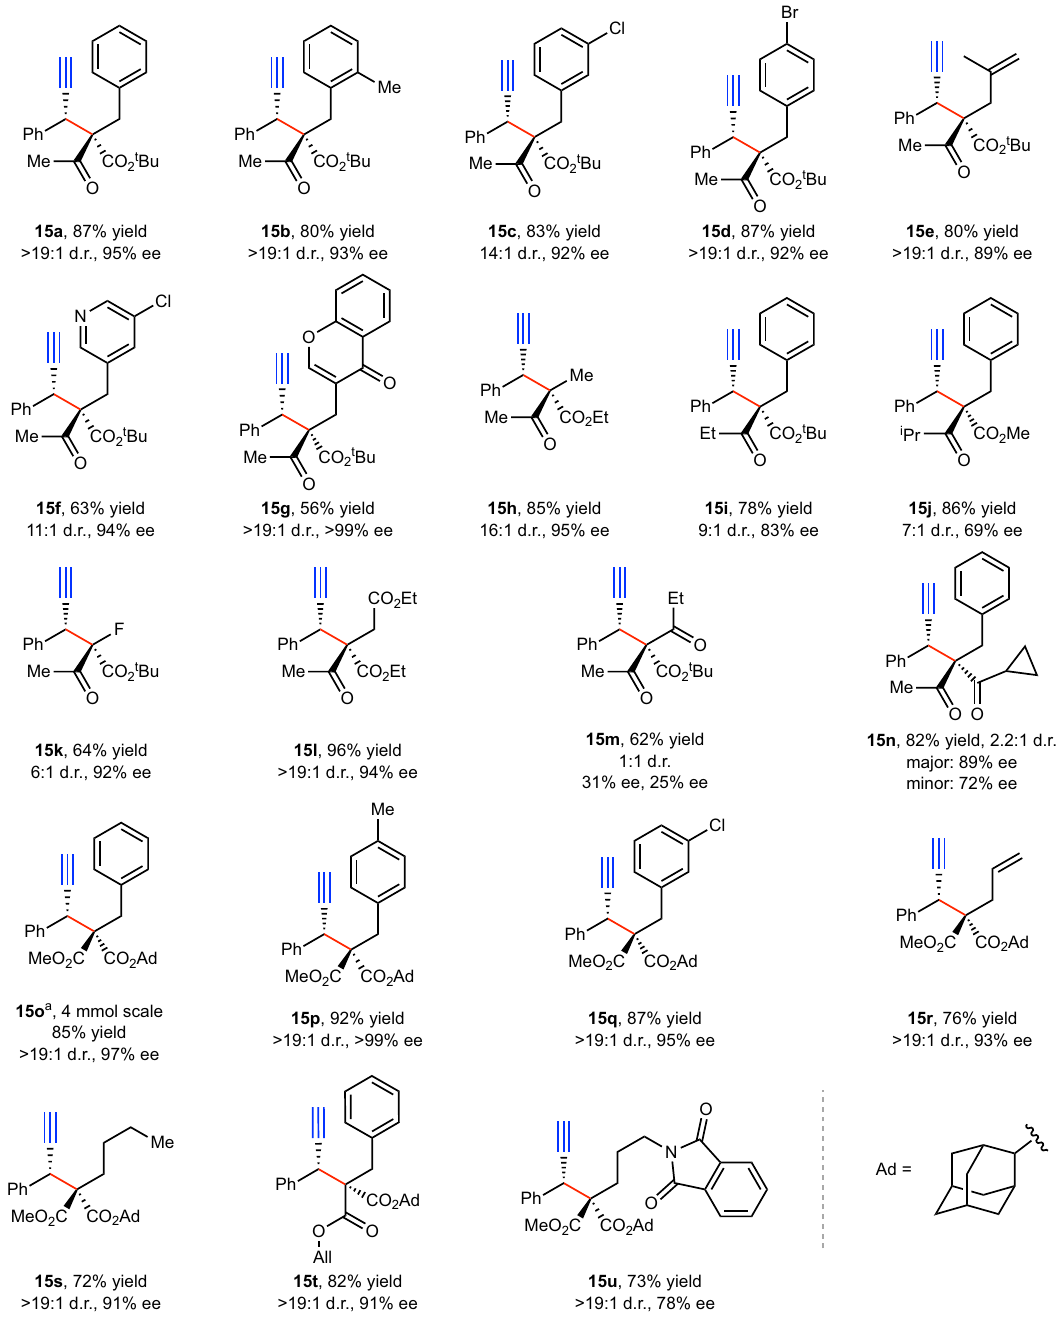
Fig. 4 Substrate scope with respect to nucleophiles. Reactions were performed on a 0.2 mmol scale in THF (2 mL) with 5 mol% Cu(I), 10 mol% L5 , and 20 mol% Mg(O t Bu) 2 . Yield is that of an isolated product. The ee values were determined by HPLC analysis, the d.r. values were determined by 1 H NMR analysis of the crude reaction mixture. a Cu(CH 3 CN) 4 BF 4 (15 mol%), L5 (30 mol%), and Mg(O t Bu) 2 (50 mol%) were used. See SI for experimental